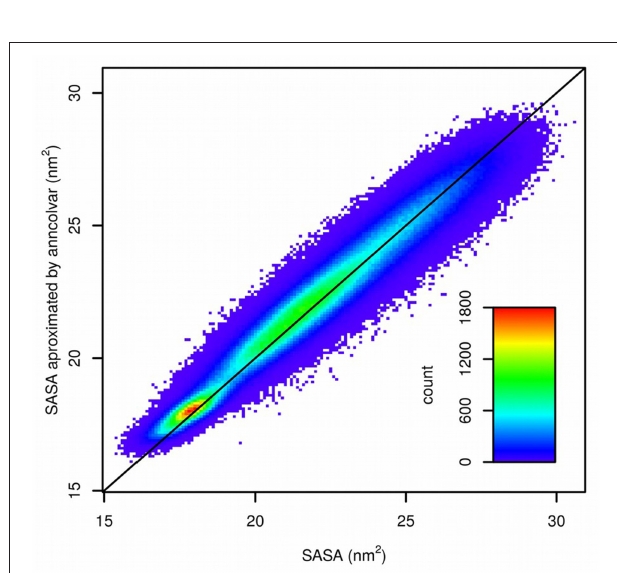
FIGURE 4 | Comparison of SASA calculated by gmx sasa (horizontal) and predicted by anncolvar (vertical). The line shows the diagonal ( y = x